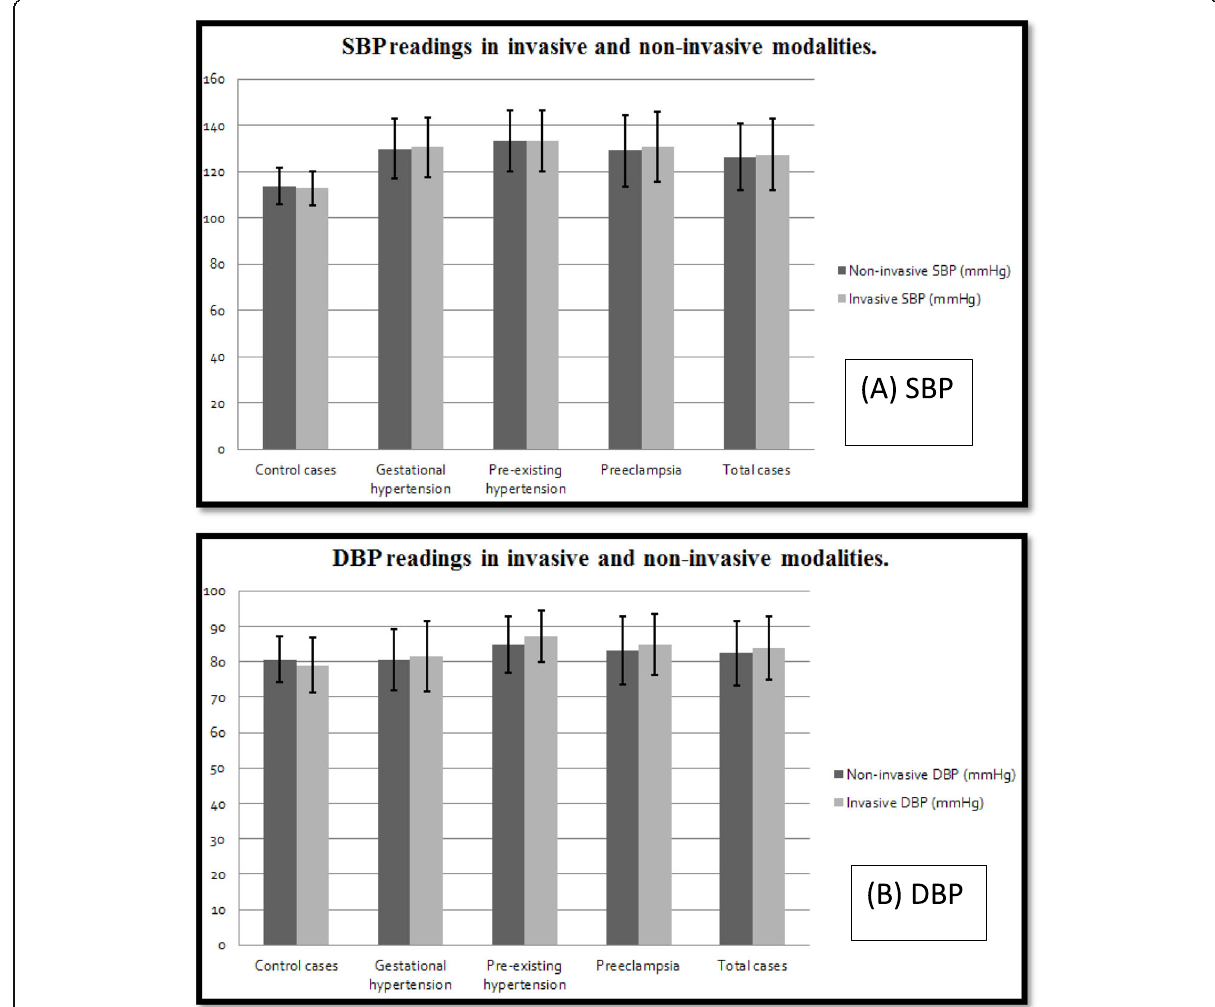
Fig. 1 a Mean systolic blood pressure in invasive vs central non-invasive modality. b Mean diastolic BP in invasive vs central non-invasive modality. SBP, systolic blood pressure; DBP, diastolic blood